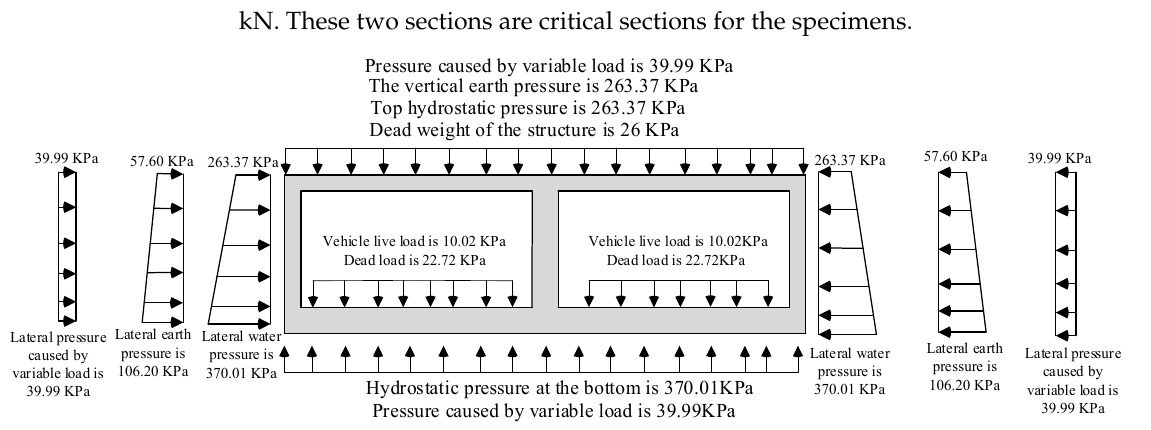
Figure 5. Schematic diagram of the load